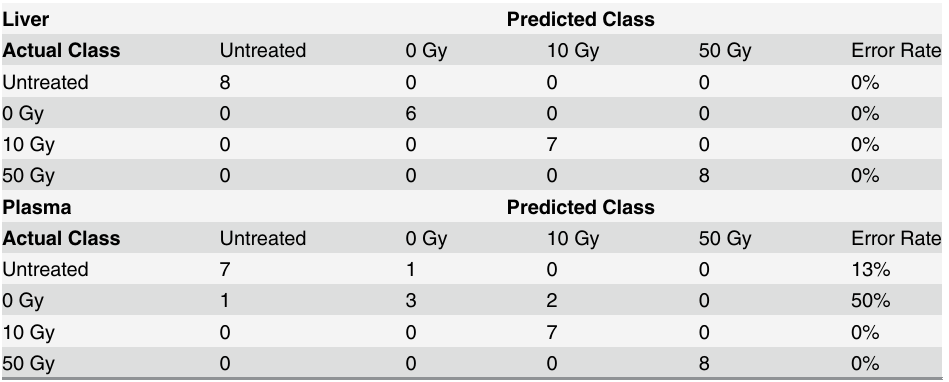
Table 4. PLS-DA classifier correctly classifies 100% of liver samples and 86% of plasma